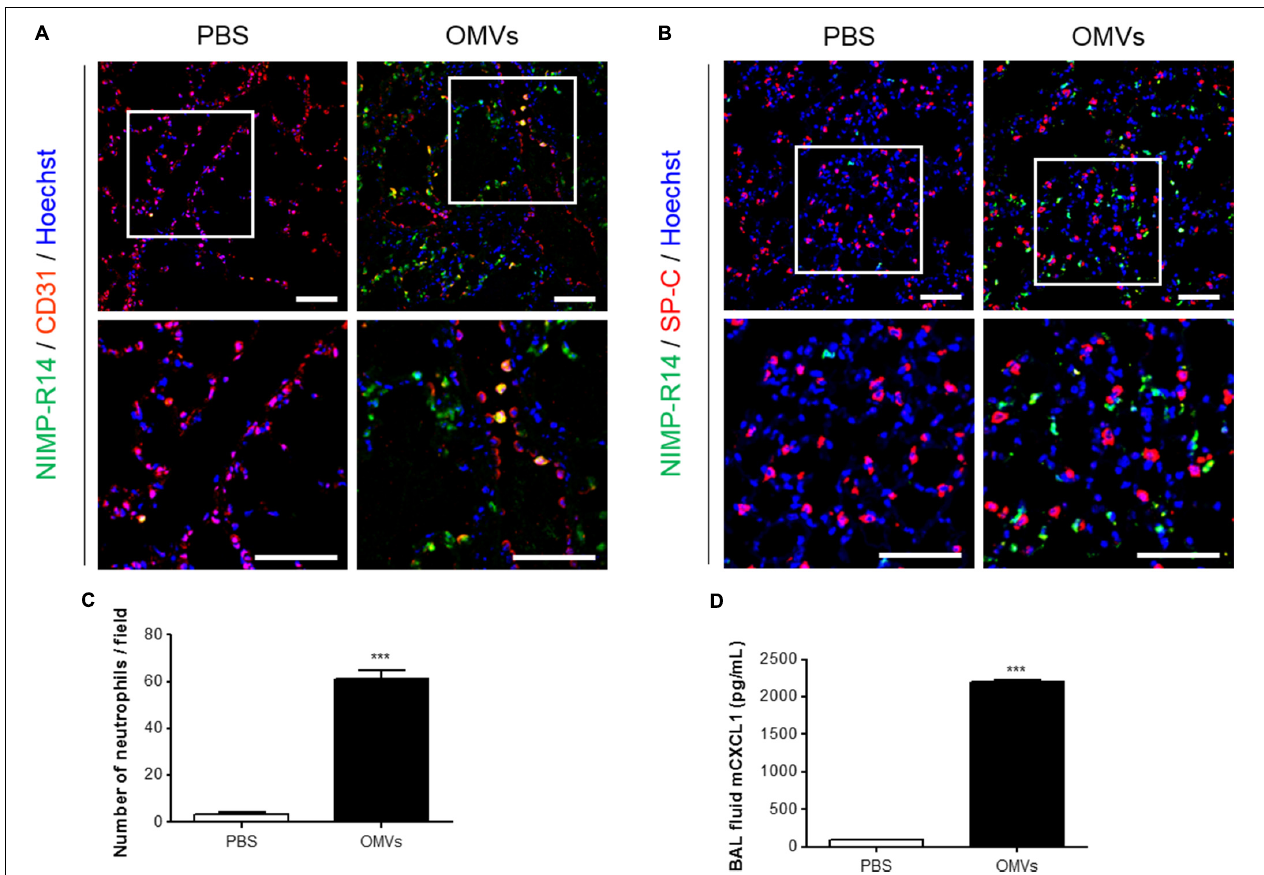
FIGURE 1 | Neutrophil transmigration in murine lungs induced by E. coli OMVs. Wild-type mice were intraperitoneally administered with either PBS or E. coli OMVs (15 µ g in total protein amounts per mouse). Five animals were used in each group. Different groups of mice administered with either PBS or OMVs were killed at 6 h after OMV administration, and the lung tissues as well as BAL fluids were obtained from the five mice. (A–C) The lung sections of five mice were immunostained with anti-NIMP-R14 (green; neutrophils) and anti-CD31 (red; endothelial cells) antibodies (A) , or anti-NIMP-R14 (green; neutrophils) and anti-SP-C (red; lung epithelial cells) antibodies (B) . The sections were then counterstained with Hoechst 33258 (blue; nuclei). Representative fluorescence images are shown here. Scale bars = 50 µ m. The number of neutrophils per field was counted from five confocal microscopy images obtained from the lung sections of five mice (C) . (D) The concentration of CXCL1 was measured in the BAL fluid by ELISA ( n = 5). Data were represented as mean ± SEM. ∗∗∗ P < 0.001, calculated by unpaired Student’s t